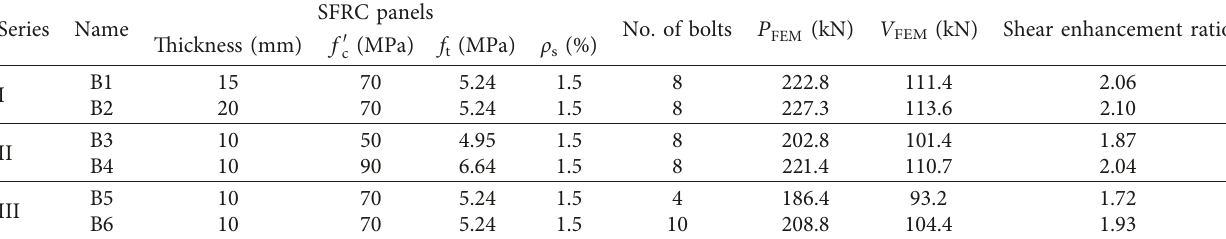
Table 6: Summary of experimental and analytical results.